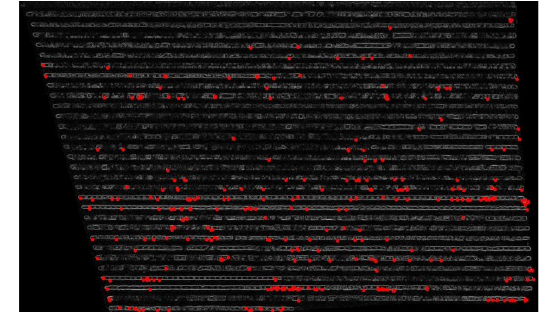
Figure 7. Harris transformation of the treed region image for Orchard#1. The red dots represent local DN maxima that correspond to trees.